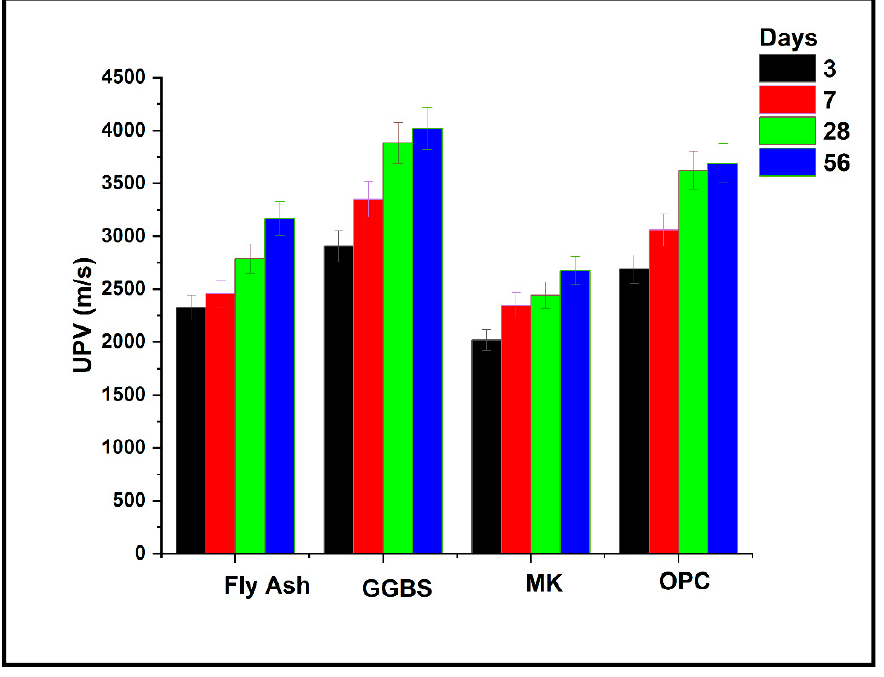
Figure 8. UPV of Mortar at 3, 7, 28 and 56 days.